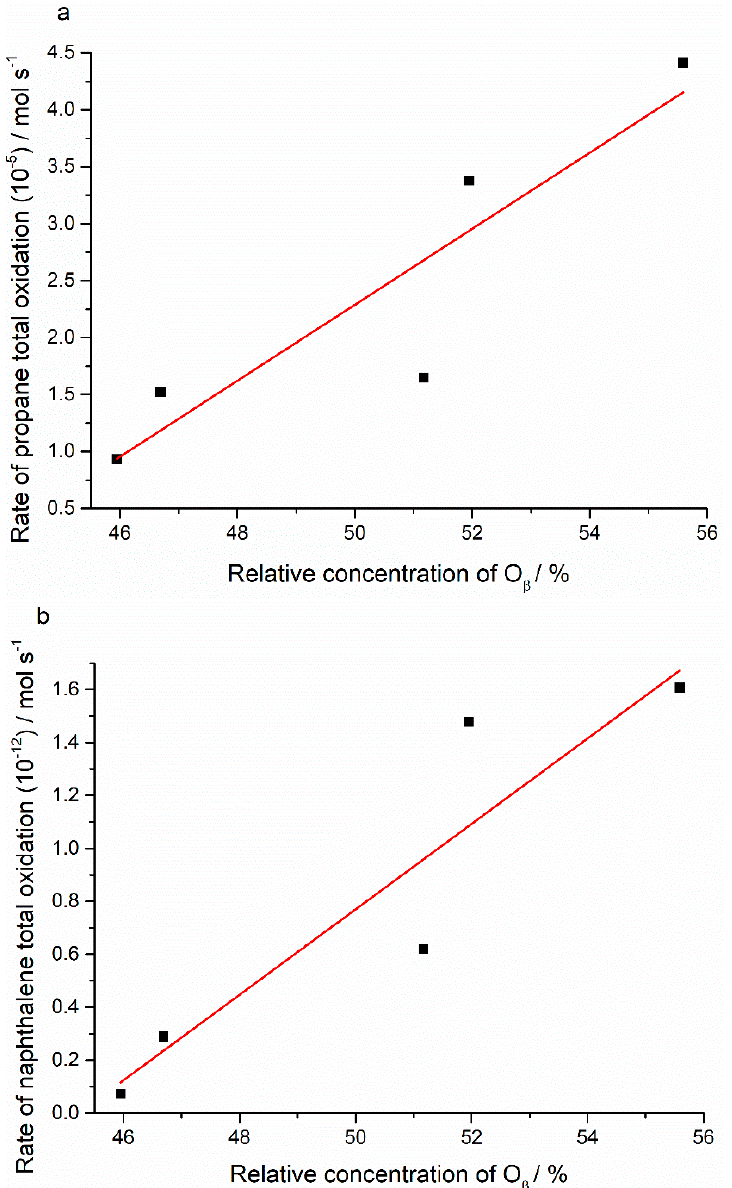
Figure 9. The correlation between the relative surface concentrations of O β measured by XPS and the catalyst activity of ceria–zirconia for total oxidation, ( a ) propane total oxidation activity at 350 °C, and ( b ) naphthalene total oxidation activity at 200 °C.